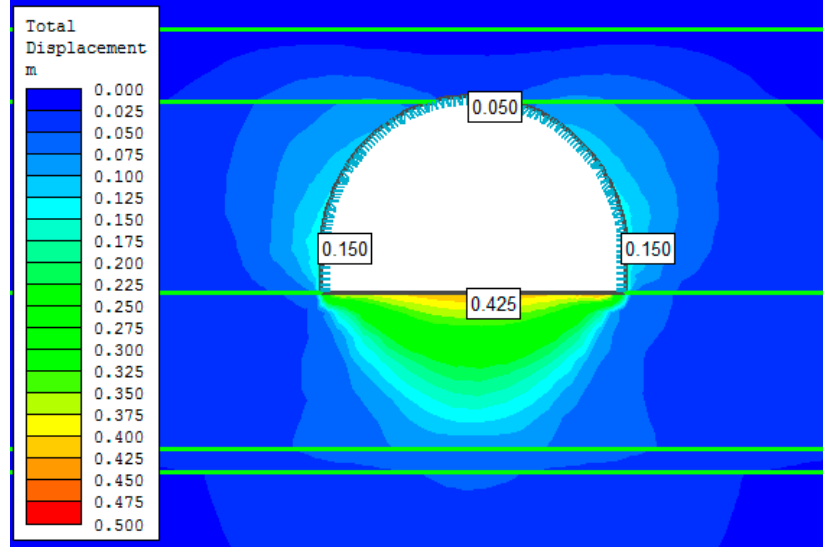
Figure 11. Model no. 6 elasto-plastic with 20% post-failure strength weakening of the rock mass—map of total displacements around the opening.